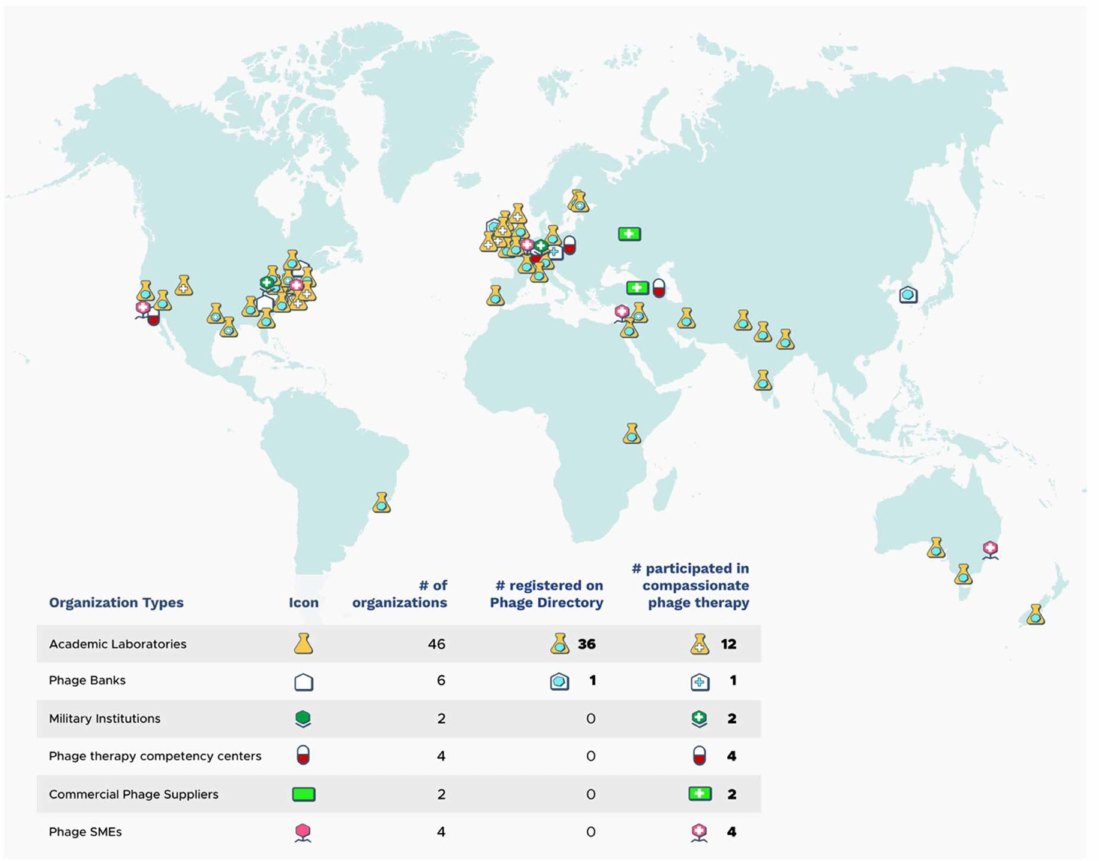
Figure 2. Geographic distribution of organizations (grouped by type) that have either previously participated in cPT cases or demonstrated intent to do so in the future through registration with Phage Directory (numbers current as of January 2019). Phage organizations not having yet contributed to cPT are not listed here. SME: Small- and medium-sized